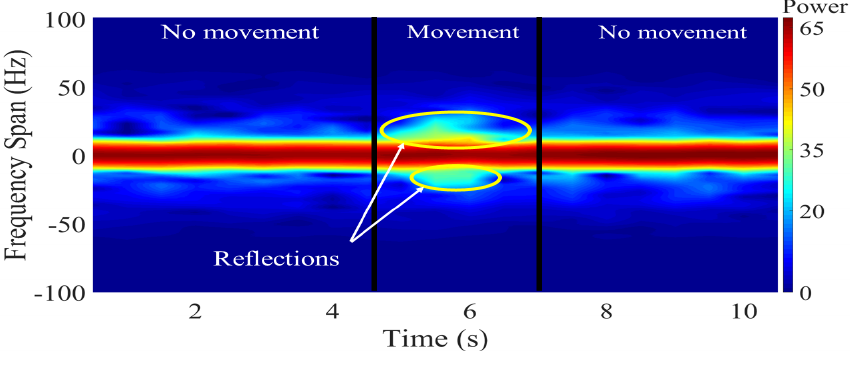
Figure 2. Spectrogram during a falling